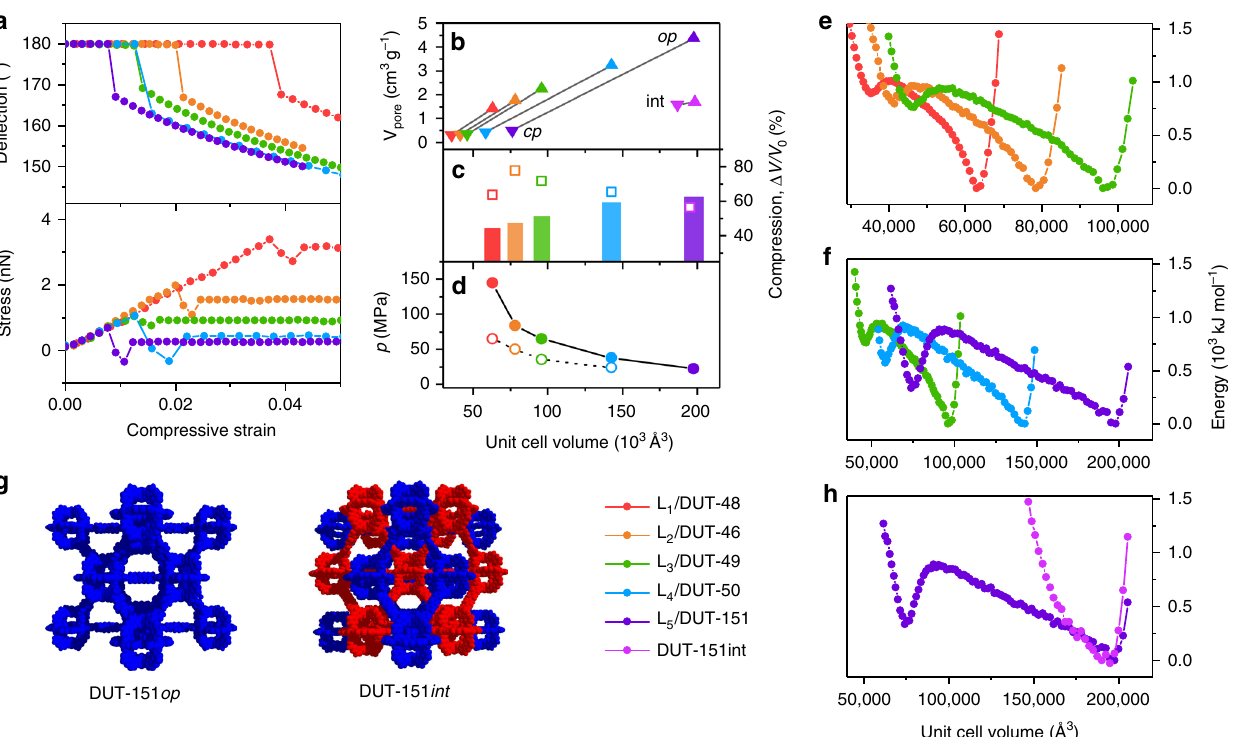
Fig. 2 Mechanical properties of ligands and MOFs. a DFT analysis of ligands L 1 (red), L 2 (orange), L 3 (green), L 4 (blue), and L 5 (purple). b Evolution of pore volume upon contraction in the open (triangles up) and closed (triangles down) states. c Compression by hydrostatic pressure (open squares correspond to Hg intrusion experiments). d Transition pressures under hydrostatic compression (open circles correspond to Hg intrusion experiments). e , f Free energy pro fi les of non-interpenetrated MOFs per unit cell. g Structures of non- and double-interpenetrated DUT-151. h Free energy pro fi les of DUT-151 and DUT-151 int . Colour code: DUT-48 (red), DUT-46 (orange), DUT-49 (green), DUT-50 (blue), DUT-151 (purple) and DUT-151 int (pink). Closed symbols represent simulation, open symbols experimental